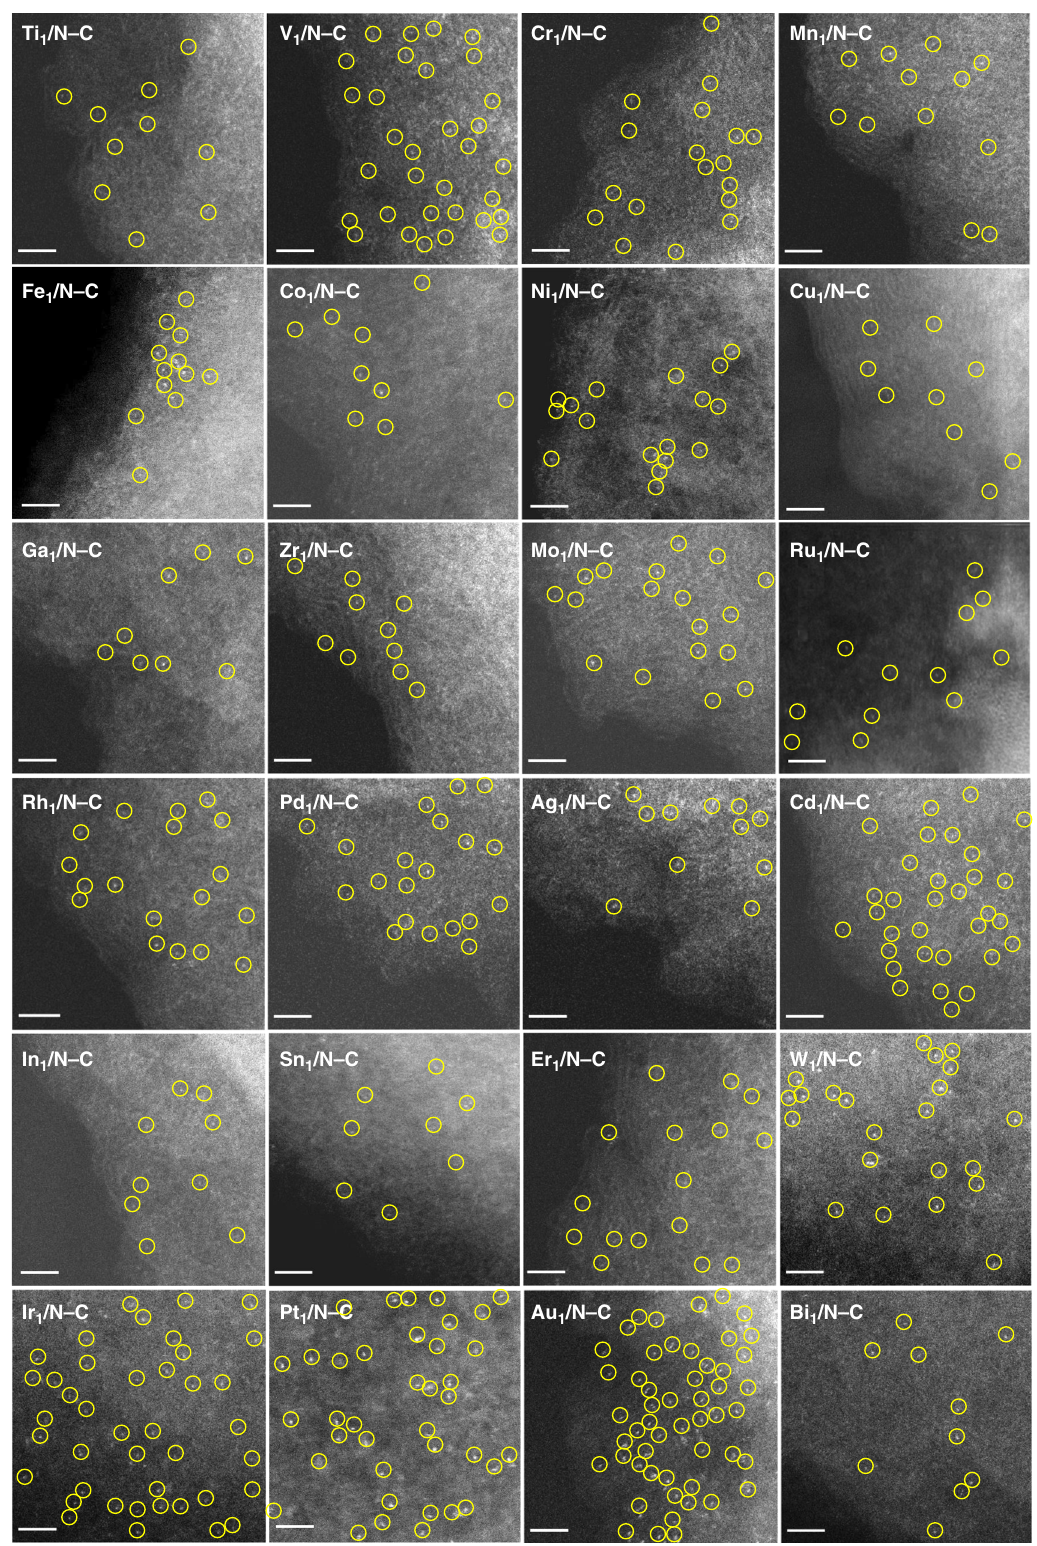
Fig. 2 AC HAADF-STEM images of M 1 /N – C. M = Ti, V, Cr, Mn, Fe, Co, Ni, Cu, Ga, Zr, Mo, Ru, Rh, Pd, Ag, Cd, In, Sn, W, Ir, Pt, Au, and Bi. SAs were highlighted by yellow circles. Scale bar, 2